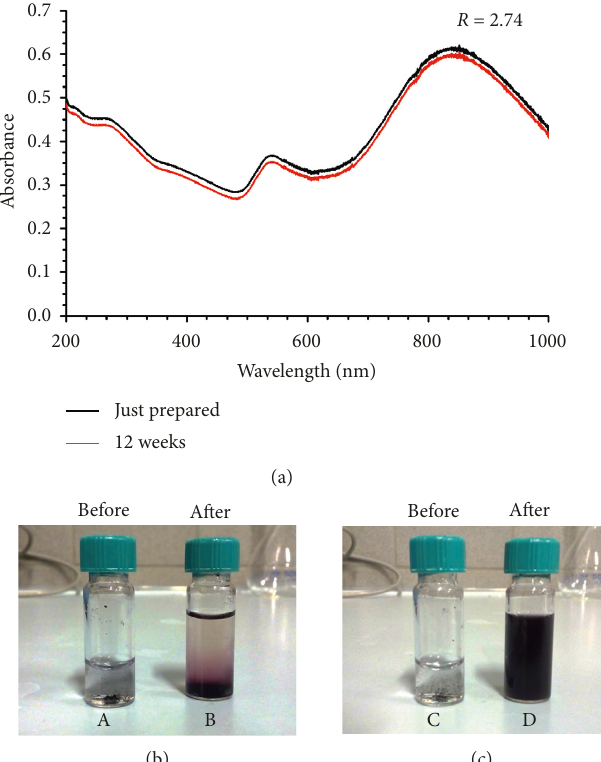
Figure 10: (a) Spectra of colloidal solutions of CC-AuNPs synthesized with R CC-AuNPs (c) before (A, C) and after (B, D) 5min